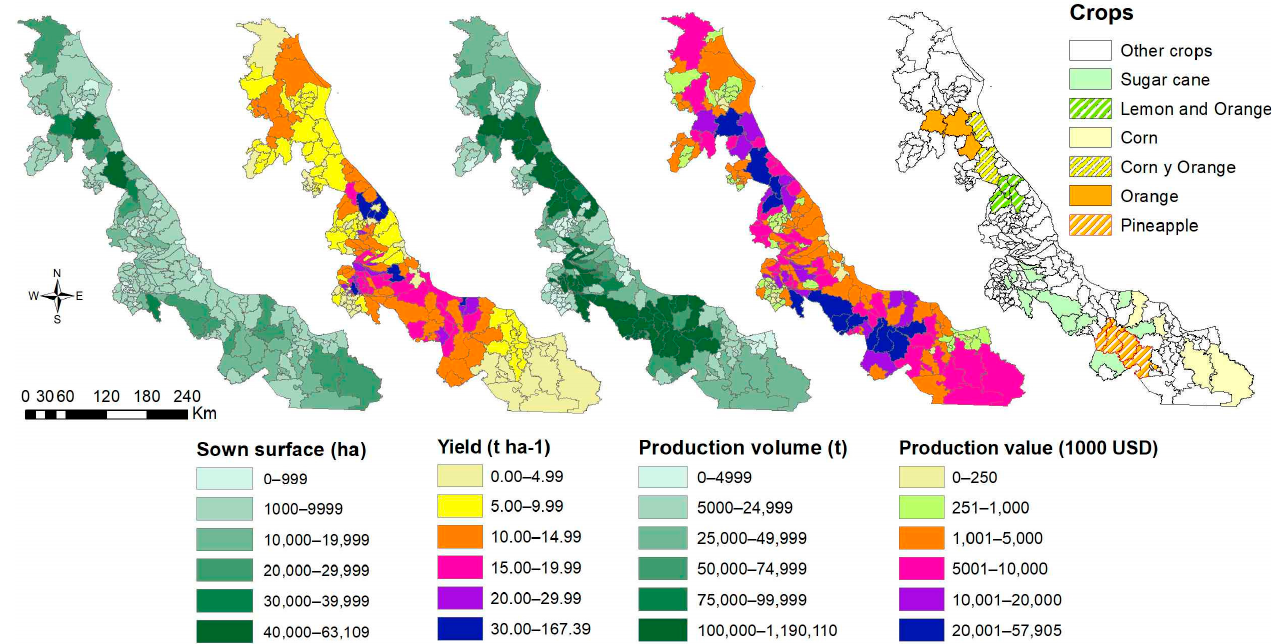
Figure 3. Average agricultural data in the municipalities of the State of Veracruz during the period (2003–2020) and location of the entities with the five highest production values of sugar cane, lemon, orange, corn, and pineapple. Source: data projected with statistical information from the Mexican National Agrifood System [5]. Table 1. The five crops with the highest production values, their sown surface, and their number of municipalities in Veracruz state during 2020.